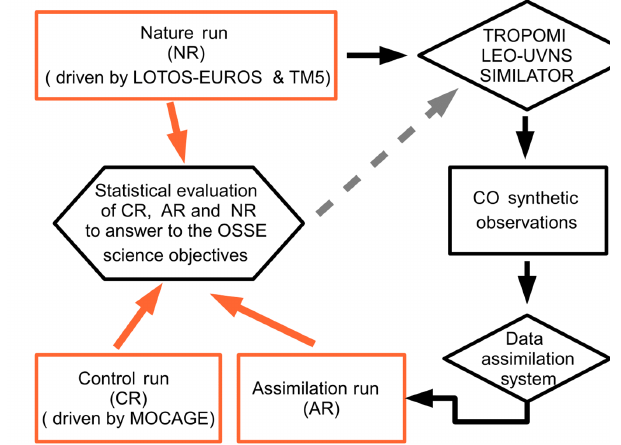
Figure 1. Diagram of the Observing System Simulation Experi- ments (OSSE) components (see text for details of each of the el-